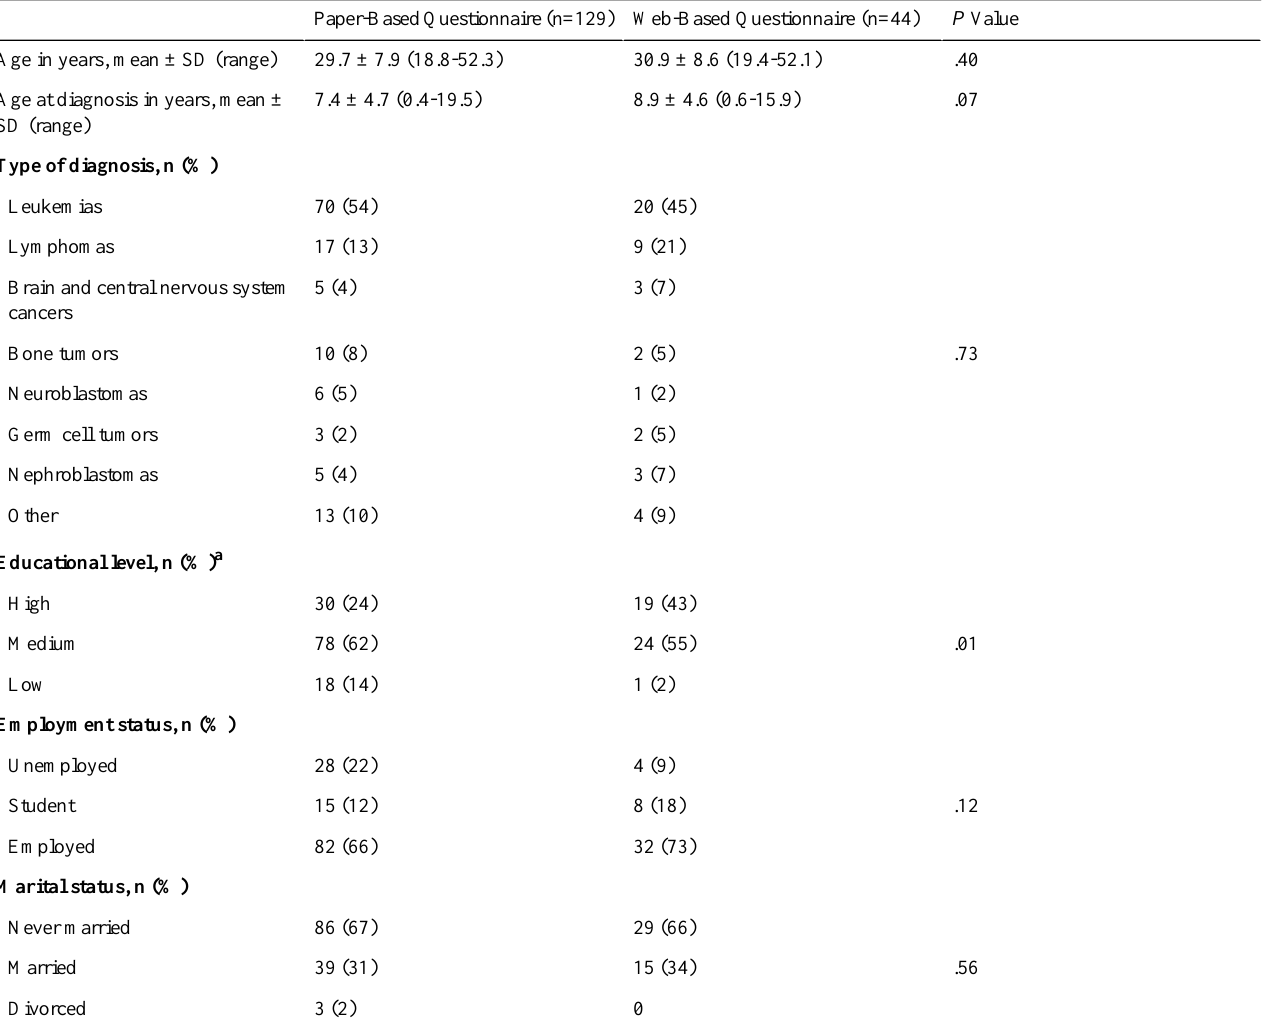
Table 2. Characteristics of respondents who filled out the paper-based and the Web-based questionnaire (n = 173)